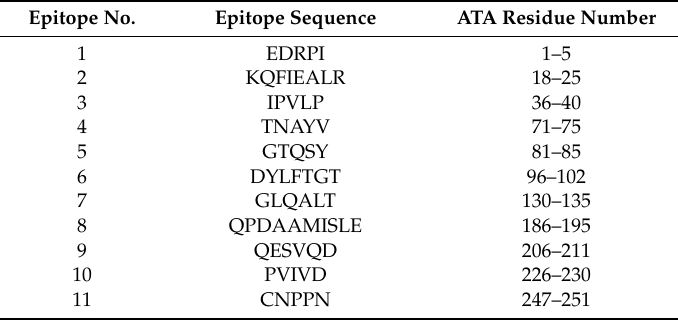
Table 2. ATA immunodominant